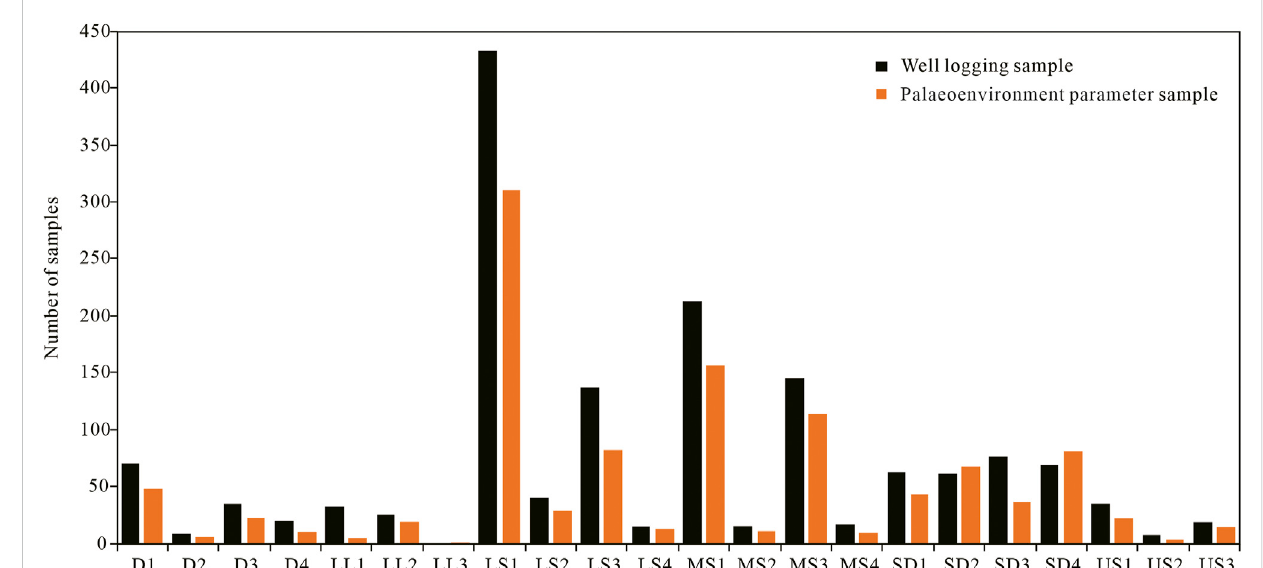
FIGURE 5 Sample quantities for different lithofacies types.